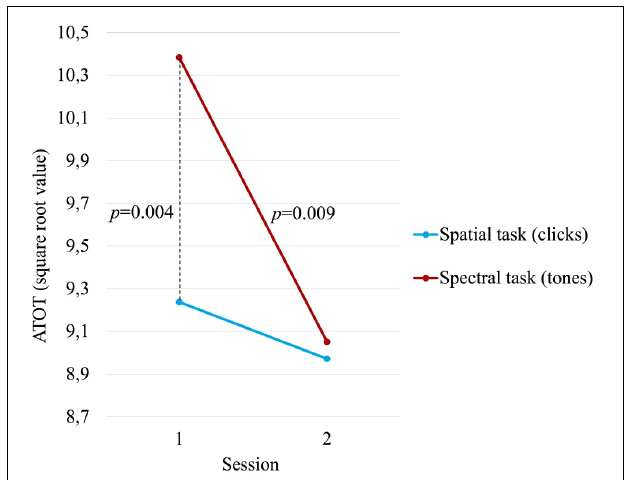
FIGURE 3 | The main effect of ‘Session’ modified by the interaction ‘Session x Task’ indicated in a 2-way ANOVA performed on transformed square root values of